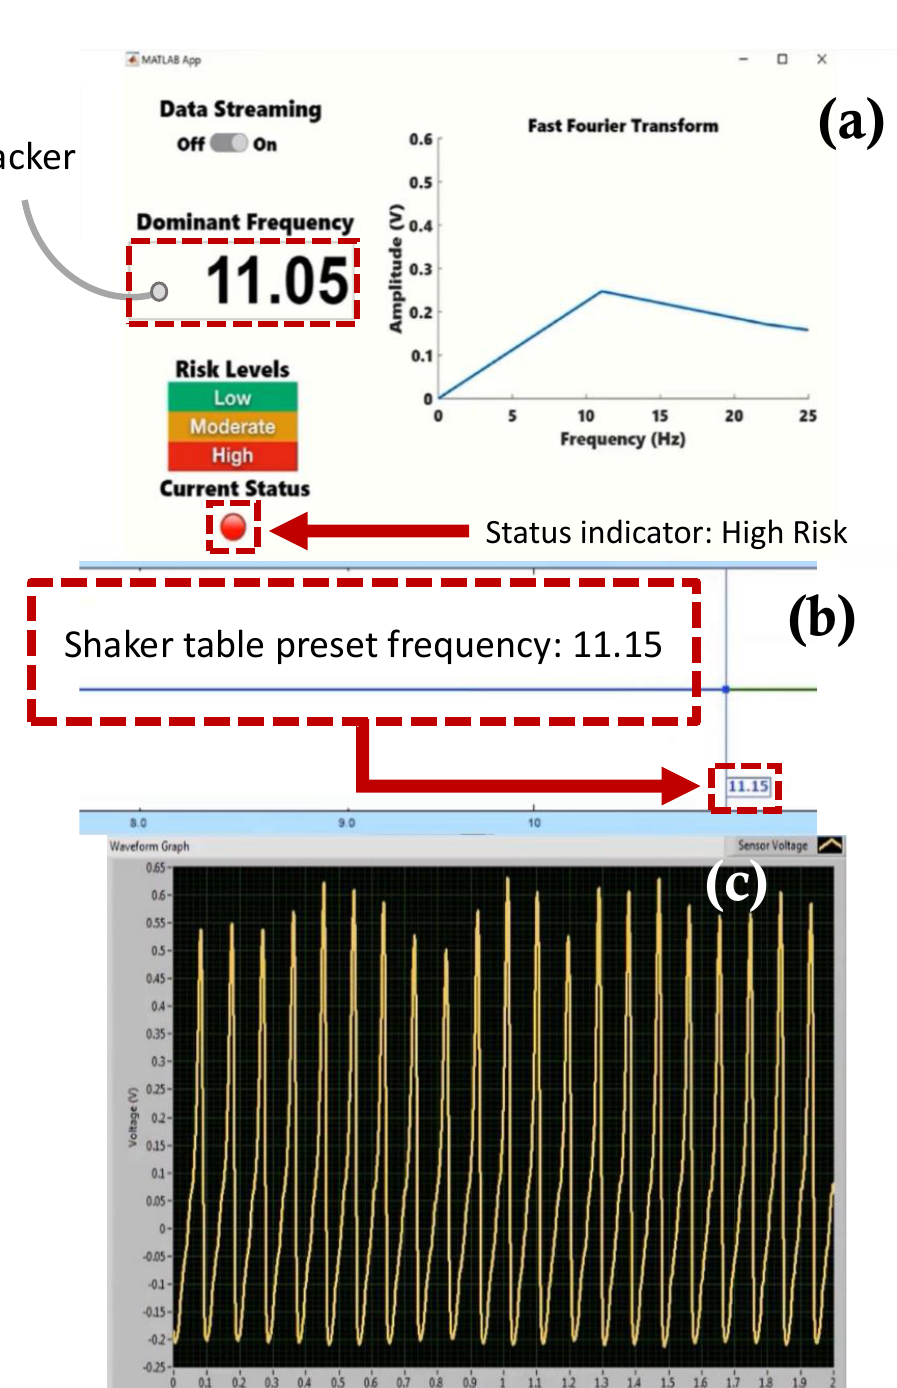
Figure 20. Screen captures of the self − powered, self − contained, vibration sensor system taken from the demonstration experiment: ( a ) custom developed fault detection app with a frequency tracker feature and status indicator for risk monitoring, ( b ) EDM shaker table vibration control software with preset frequency monitor, ( c ) sensor voltage waveform monitor at preset frequency 11.15 Hz.